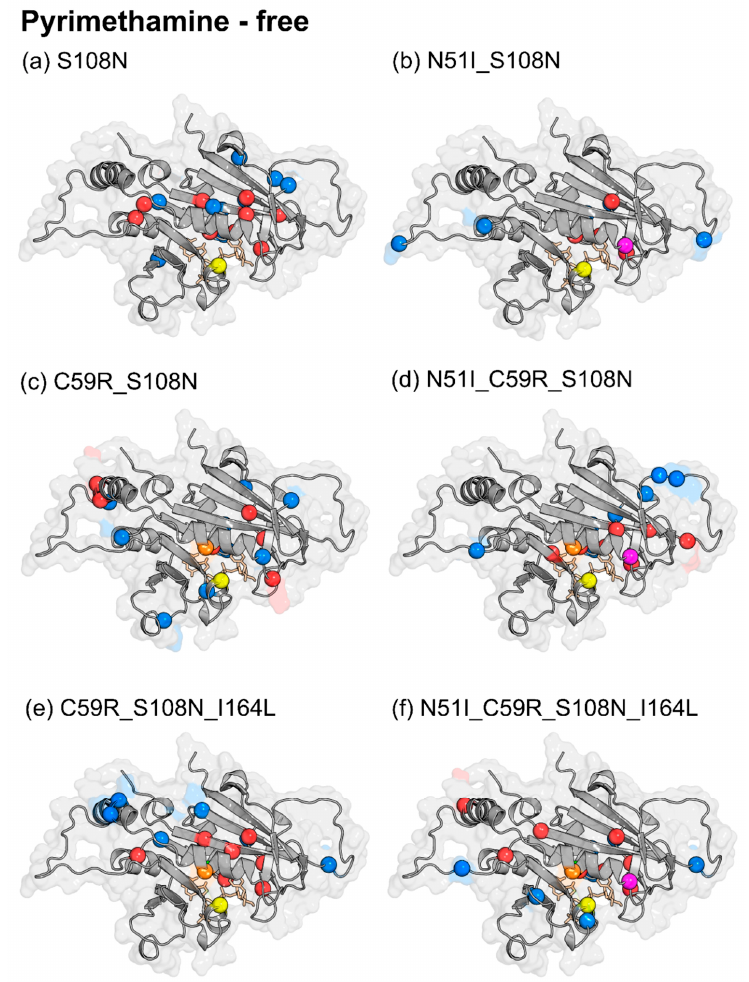
Figure 8. Effects of mutations on intra-protein communication: Structural mapping of residues showing significant changes in average betweenness centrality (BC). Changes in residue centrality ( Δ BC ) values were obtained by calculating WT-free less mutant-free average BC values. Residues with significant changes were obtained by using a cutoff value of +/ − 2 SD of Δ BC values for each system. Red spheres represent residues with positive Δ BC values, while blue spheres are residues with negative Δ BC values. Also shown in spheres are pyrimethamine-resistant point mutations studied here: Color key: magenta: N51I, orange: C59R, yellow: S108N, and green: I164L.